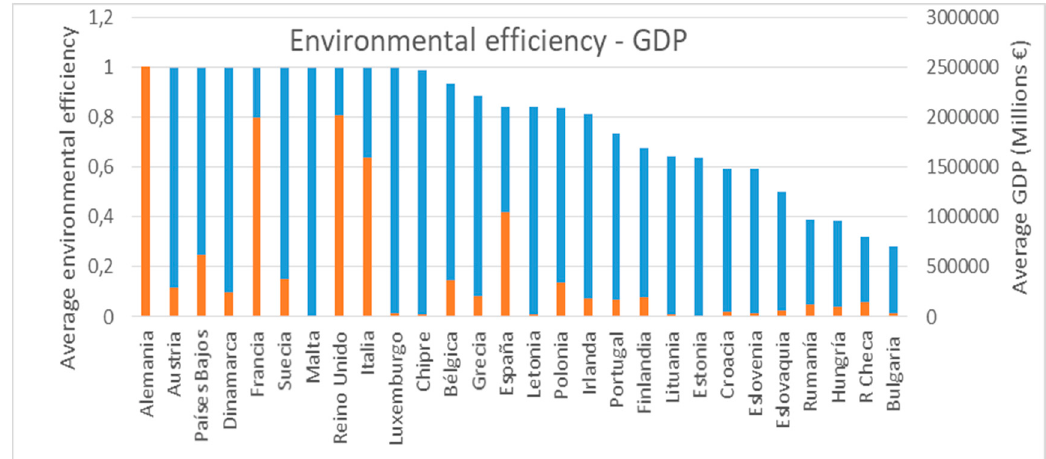
Figure 11. Values of average environmental efficiency obtained from the average environmental efficiency data of Method 1 and average environmental efficiency of Method 2. Source: own calculations.